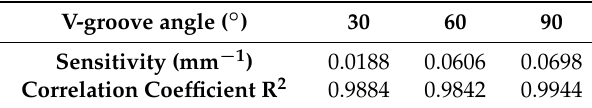
Figure 5. Sensing performances for POF probes with different V-groove angles of 30 ◦ , 60 ◦ , and 90 ◦ , where the V-groove pitch and depth are 2.5 mm and 300 µ m, respectively, and the refractive index of the liquid is 1.39. Table 2. The results coming from Figure